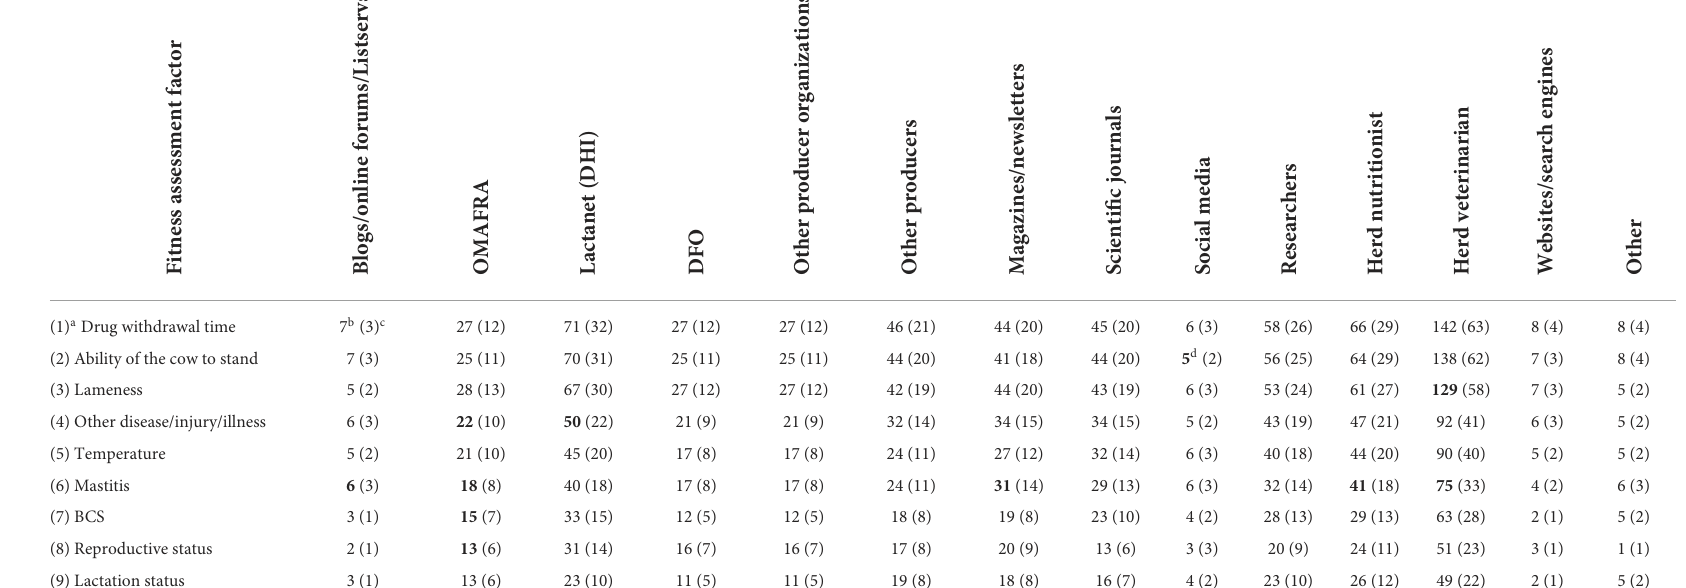
TABLE 3 The ranked importance of cull cow fitness assessment factors by that of information sources for cull cow